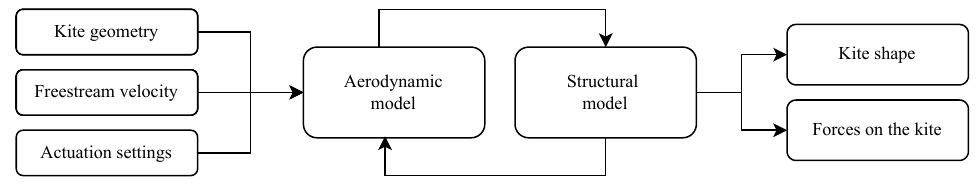
Figure 6. Flowchart of the coupled aero-structural